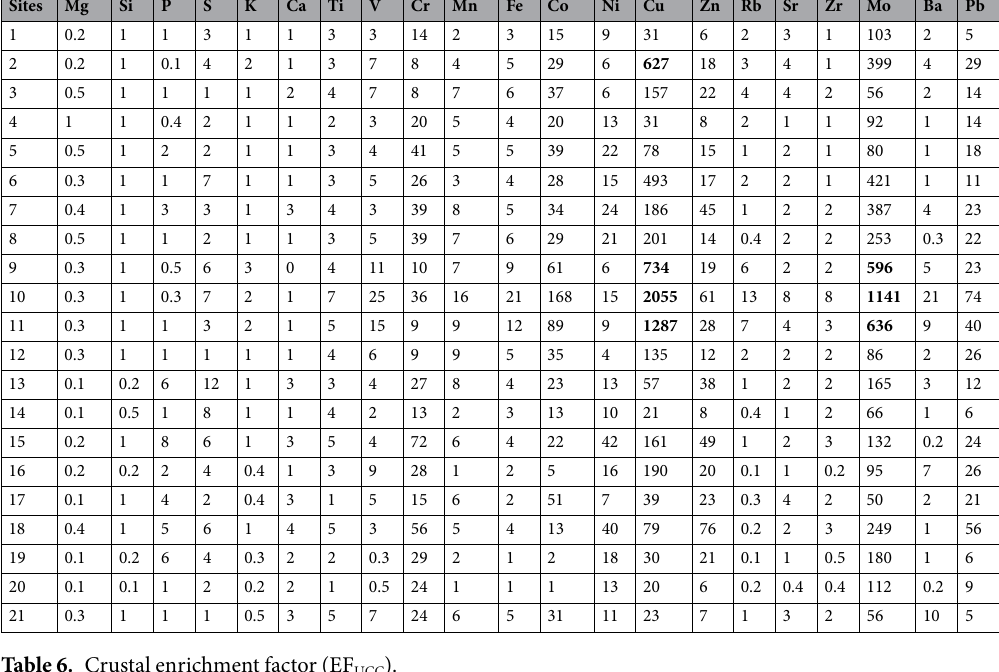
Table 6. Crustal enrichment factor (EF UCC ).